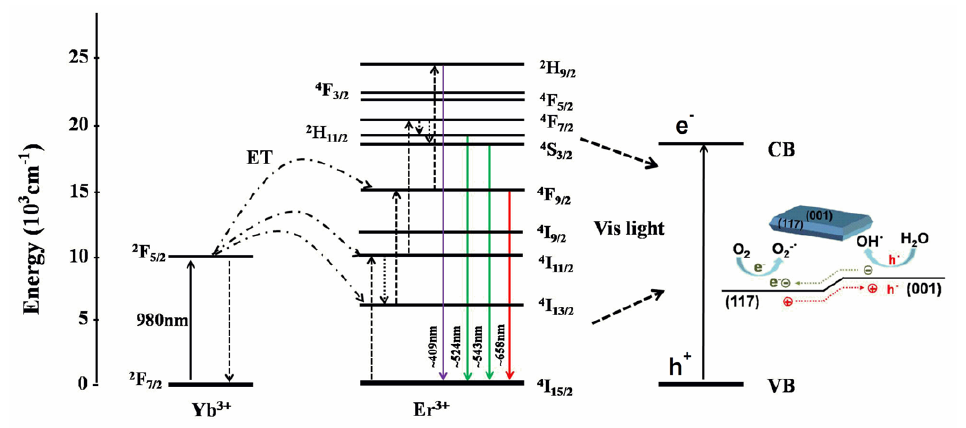
Figure 7. Energy level diagram and the energy transfer between Yb 3+ and Er 3+ showing the proposed upconversion mechanism under 980 nm excitation. The photoexcitation of BFCTO by the upconversion emission in the Vis region is also shown.